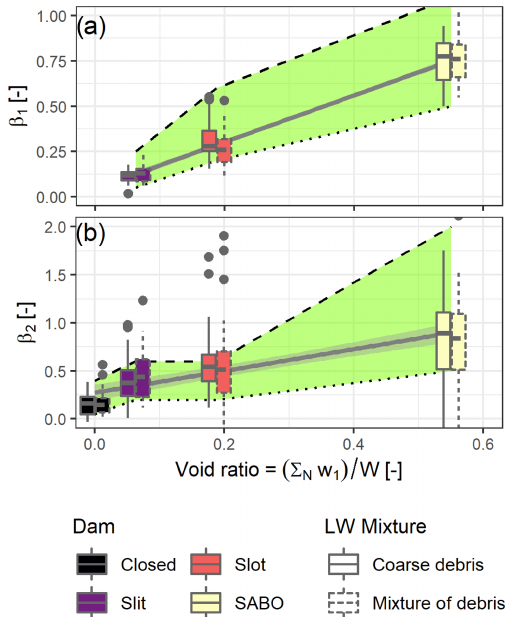
Figure 12. Variability in β 1 and β 2 versus void ratio for all dams. Boxes display first, second and third quartiles; points are outliers higher than 1.5 times the interquartile range. Grey lines are linear fits on all data highlighting the increasing trends. The light grey rib- bon and dotted lines show the upper and lower bounds fitted for each dam. Overall head loss coefficients increase with barrier per- meability, but the presence of fine material or only of coarse debris has marginal